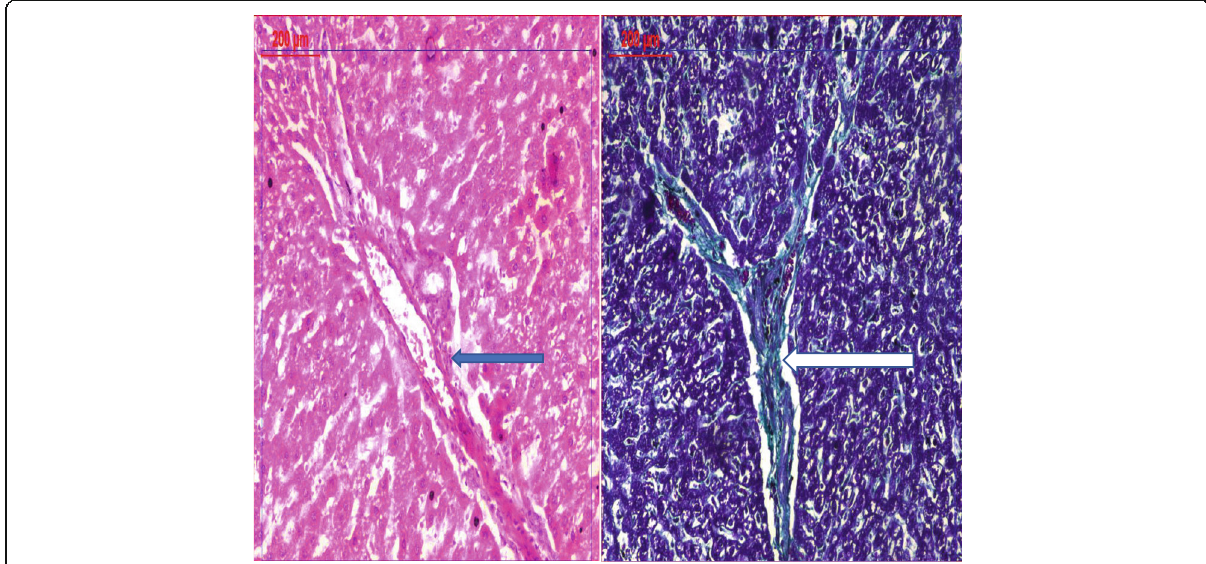
Fig. 7 Photomicrograph for the prophylactic group: showing liver tissue with minimal portal fibrosis and insignificant inflammatory response (blue arrows), demonstrated by Masson trichrome stain (white arrow) (× 200, ×